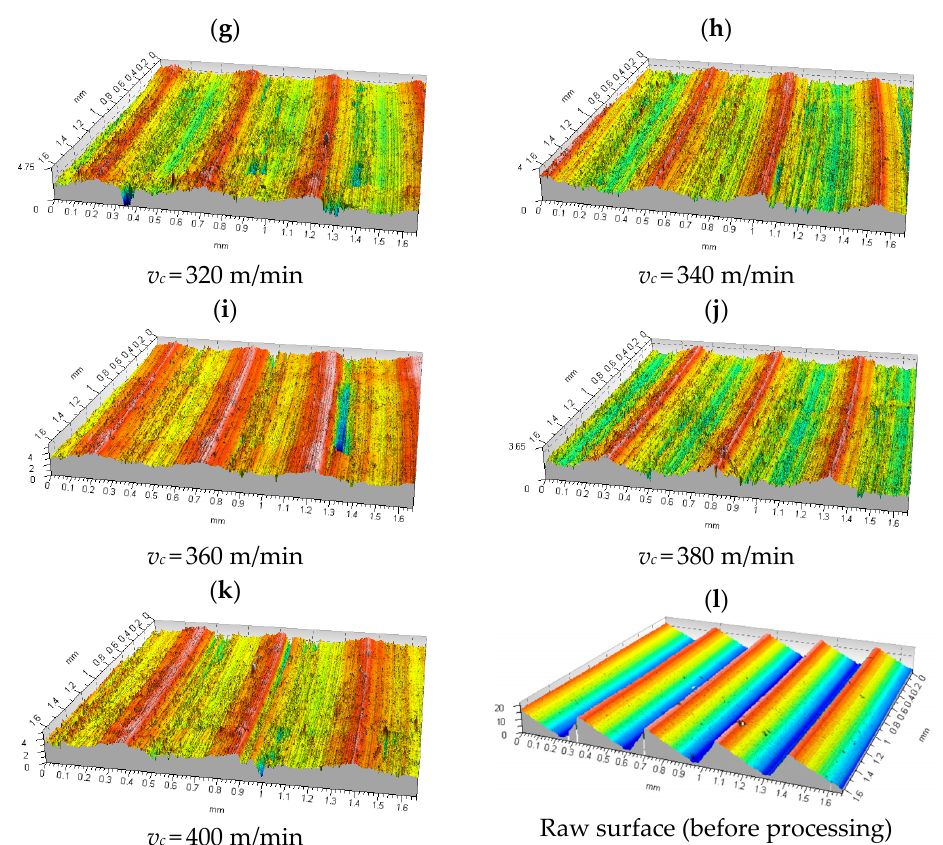
Figure 11. Summary of isometric images of the surface microgeometry of samples made of the 2017A alloy machined at variable cutting speeds. Cutting parameters: f z = 0.1 mm/tooth, a p = 0.2 mm.